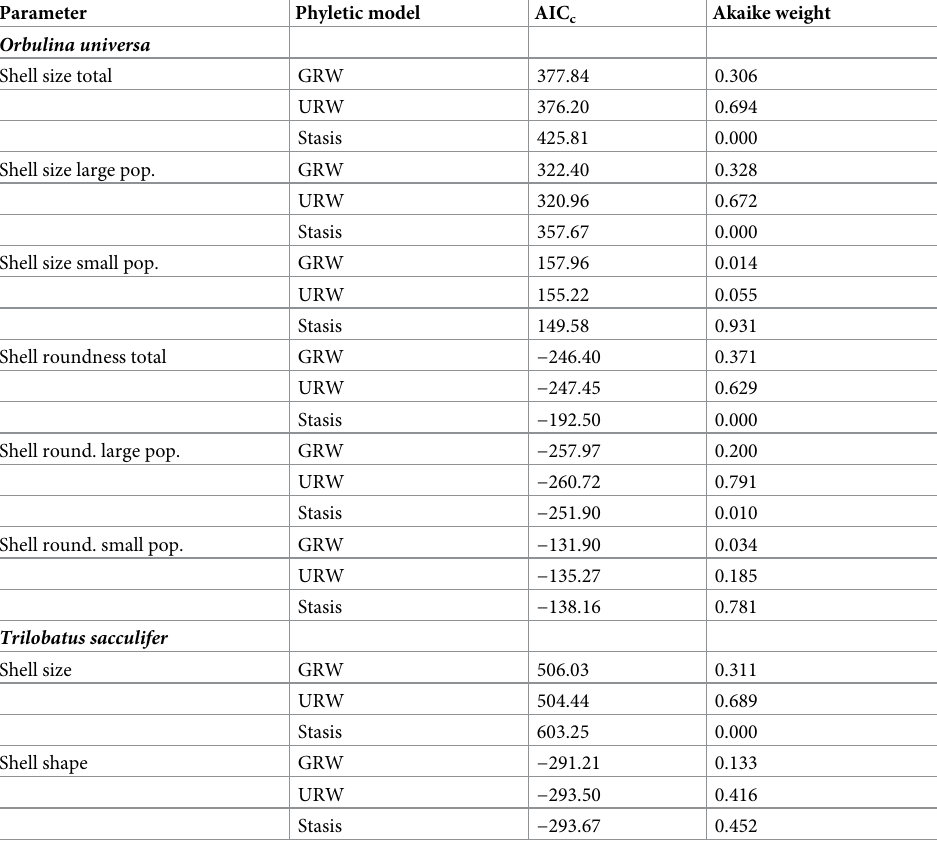
Table 1. Results of phyletic evolution models of planktonic Foraminifera in the Red Sea during marine isotope stage 12. Parameter Phyletic model AIC c Akaike